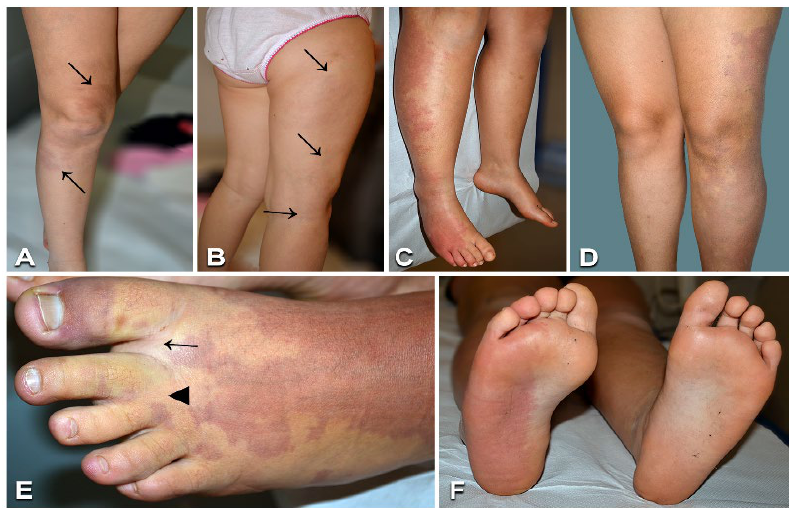
Figure 2. Clinical features of capillary malformations with overgrowth: A 7-year-old female (Table 1, n. 11) presenting red-brownish patches with blurred margins on the right thigh and leg (arrows in A ), prominent veins on the lateral aspect of the thigh (arrows in B ), and ipsilateral limb overgrowth. Eleven-year-old male (Table 1, n. 8) with a capillary malformation of the lateral region of the right lower limb, including the foot dorsum and plant ( C , F ), associated with ipsilateral lower limb overgrowth ( C ). Seventeen-year-old female (Table 1, n. 13) presenting a capillary malformation of the left lower limb, including the foot ( D , E ). Note sandal gap (arrow in E ) and proximal syndactyly of toes 2–3 (arrowhead in E